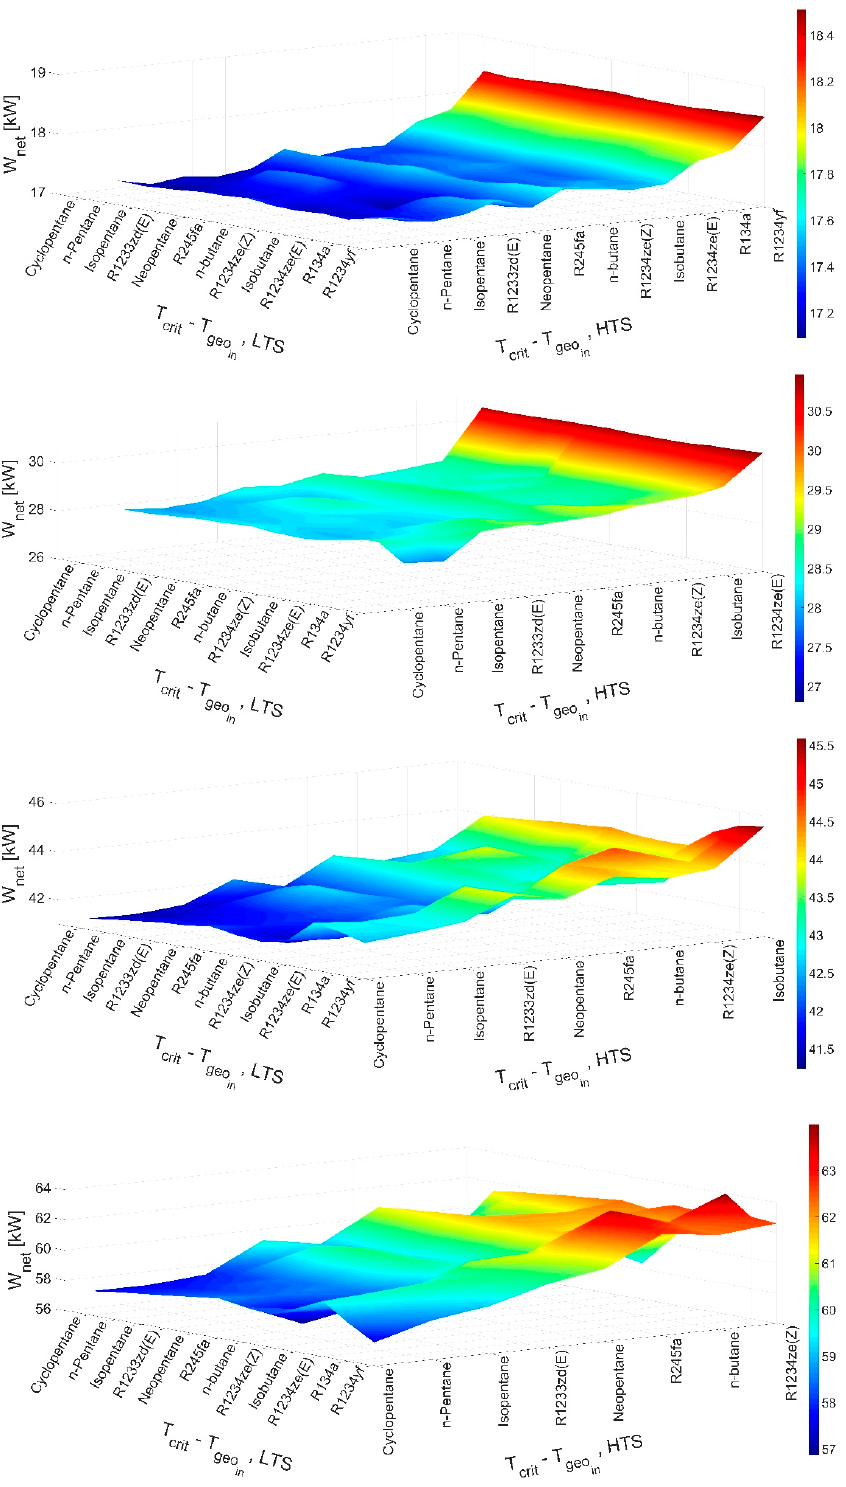
Figure 5. The net power output of the DS parHTSLTPH ORC configuration, as a function of the working fluids in the HTS and the LTS, for the geothermal heat source characteristic temperatures.